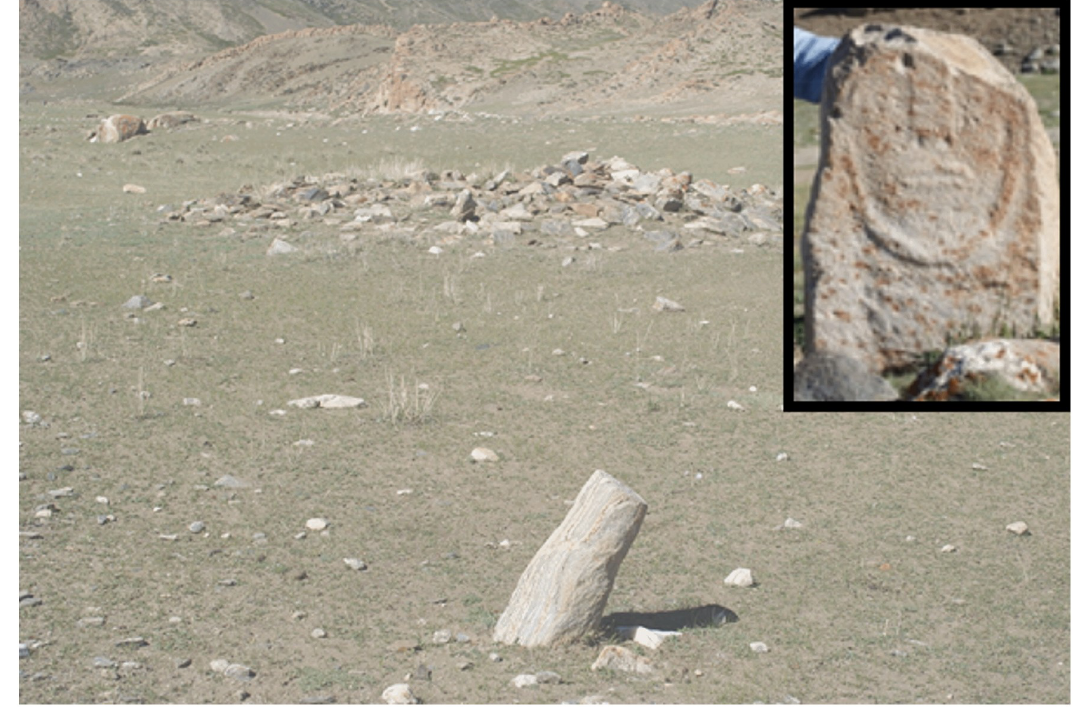
Fig 2. Chemurchek burial mound in western Mongolia, along with accompanying standing stone Fig. Photo: T. Tuvshinjargal.